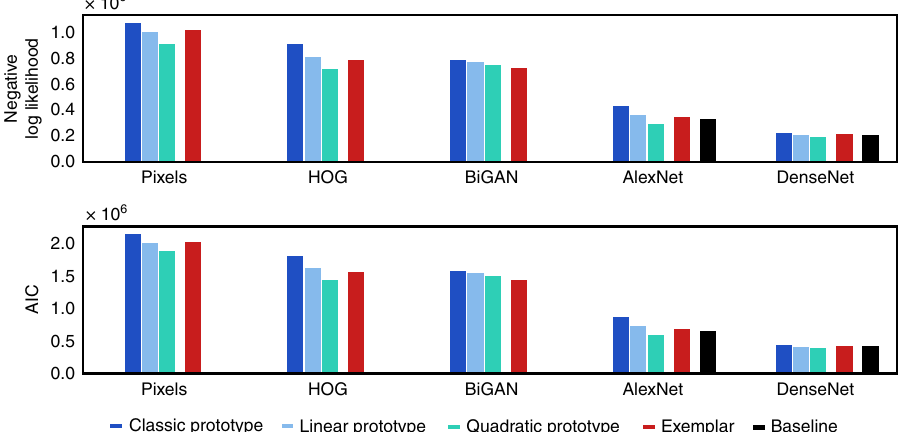
Fig. 5 Categorization model results. Negative log-likelihood and AIC results for all categorization models using all fi ve stimulus representations (lower scores mean better performance). Within each representation, models are colored and clustered by class (prototype, exemplar). Baseline model performances are shown using a black bar for relevant feature spaces (AlexNet and DenseNet). Source data are provided as a Source Data fi